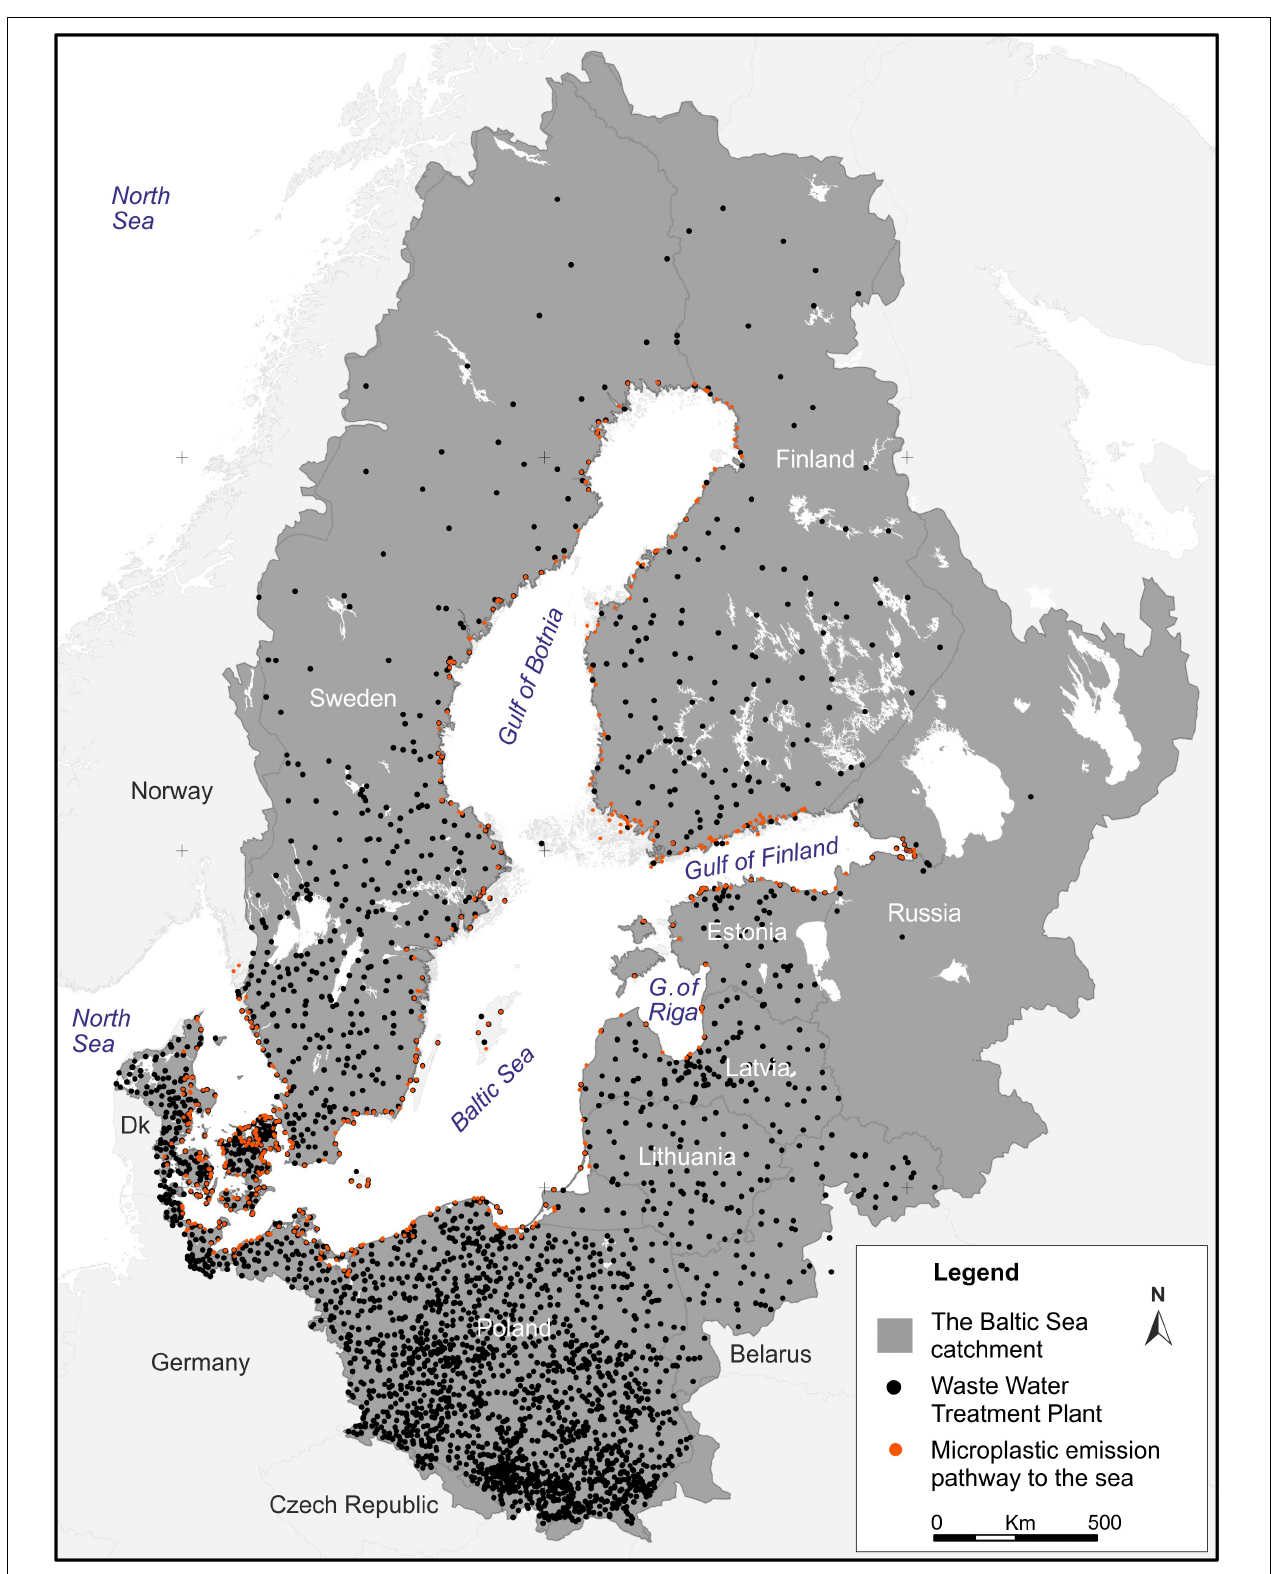
FIGURE 1 | Location of the about 3500 wastewater treatment plants (WWTPs) in the Baltic Sea catchment (black dots) and microplastics emission pathways/points (rivers and direct discharge) to the Baltic Sea.